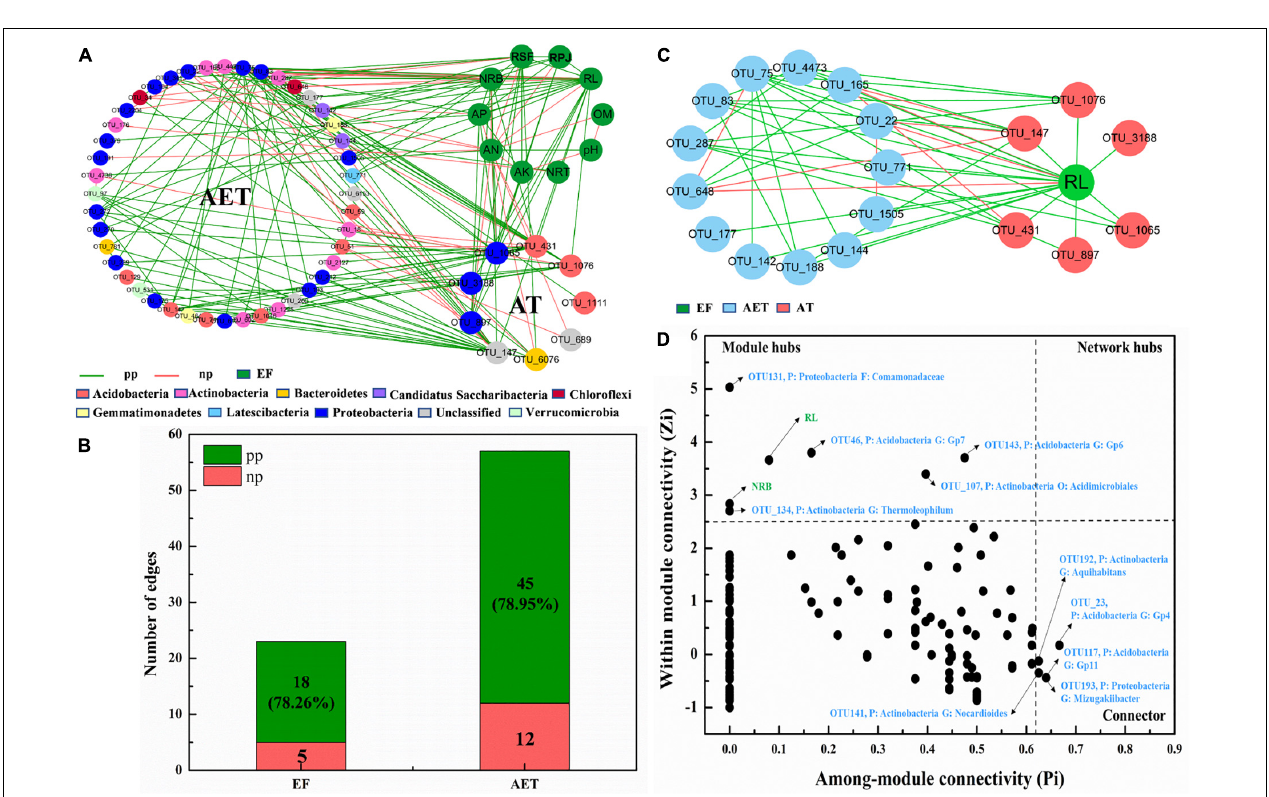
FIGURE 4 | Random matrix theory (RMT)-based molecular ecology networks (MENs). (A) Nodes (OTUs) connected to “AT” and “EF.” Green lines represent the interactions between nodes (OTUs) that are negative, and red lines represent positive interactions. EF, rhizosphere environmental variations. (B) Numbers of edges for AT connecting to EF and AET. AET, OTUs shared in four treatments; AT, special OTUs present in deep tillage treatments. pp, positive Pearson correlation; np, negative Pearson correlation. (C) Nodes (OTUs) connected to “RL”. (D) Zi–Pi graph showing “keystone” OTUs. P, phylum; G,